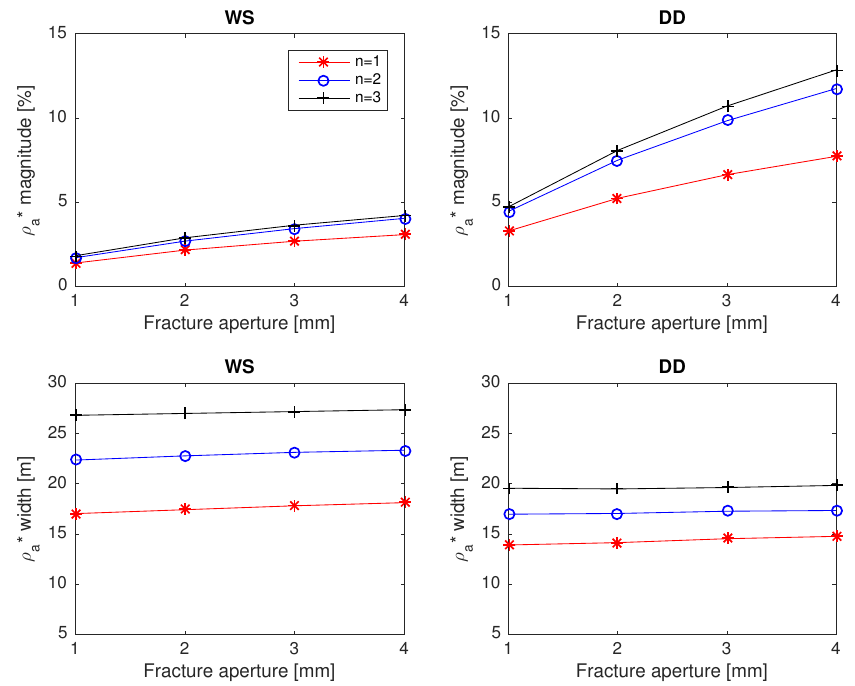
Figure 7. Apparent resistivity anomaly magnitude and width as a function of fracture aperture for the case of a single fracture having length (cid:96) = 5 m, electrical resistivity ρ f = 10 Ω · m, and dipping at 45 ◦ . The fracture is hosted in bedrock having resistivity ρ b = 10,000 Ω · m, whereas the overburden resistivity is ρ o = 1000 Ω · m. The overburden thickness is 1 m. The measurement configuration is denoted by WS (Wenner-Schlumberger) or DD (dipole-dipole) with spacing factor n . Cases 2, 12, 13, and 14 from Table 1 are